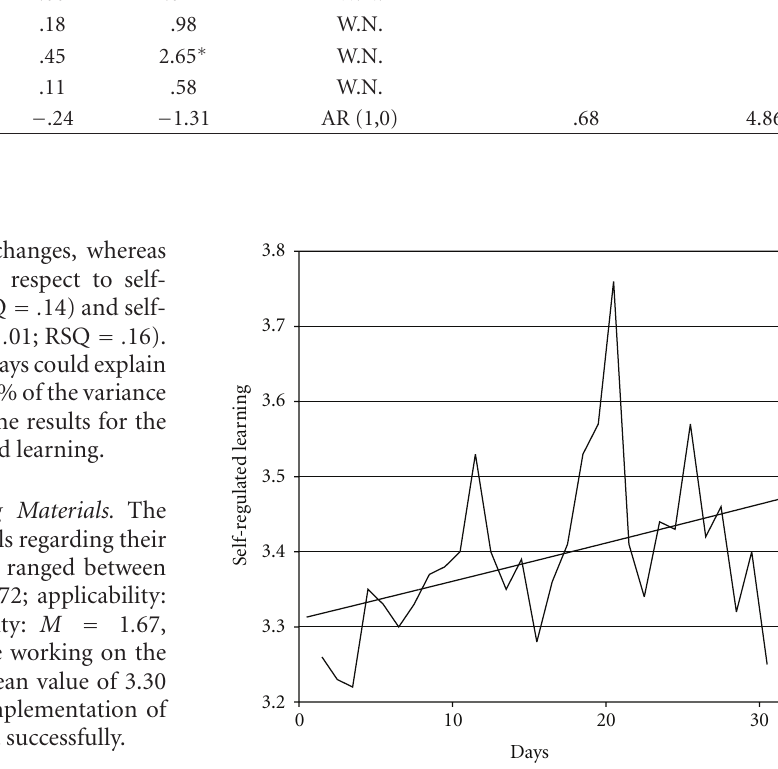
Figure 3: Trajectory and linear trend for self-regulated learning measured on a four-point